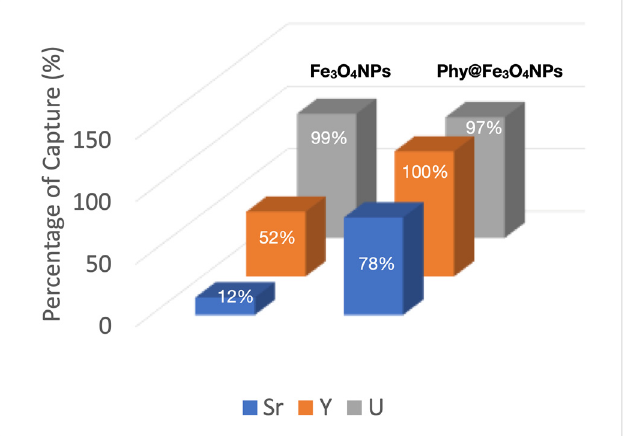
Figure 7. Capture percentages obtained for Sr(II), Y(III) and UO 22+ in a competitive test, using Fe 3 O 4 NPs and Phy@Fe 3 O 4 NPs.